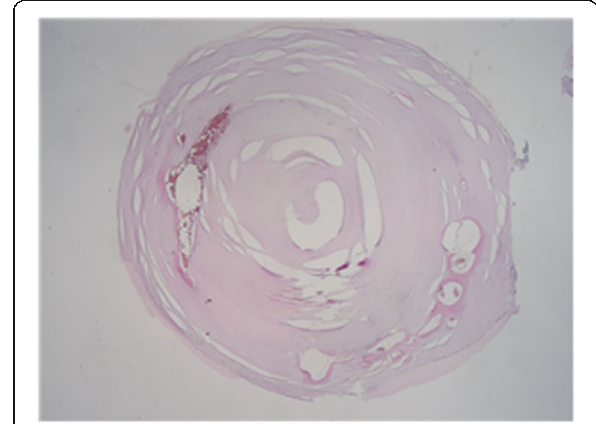
Fig. 4 Microscopic examination revealed irregular multiple calcifications